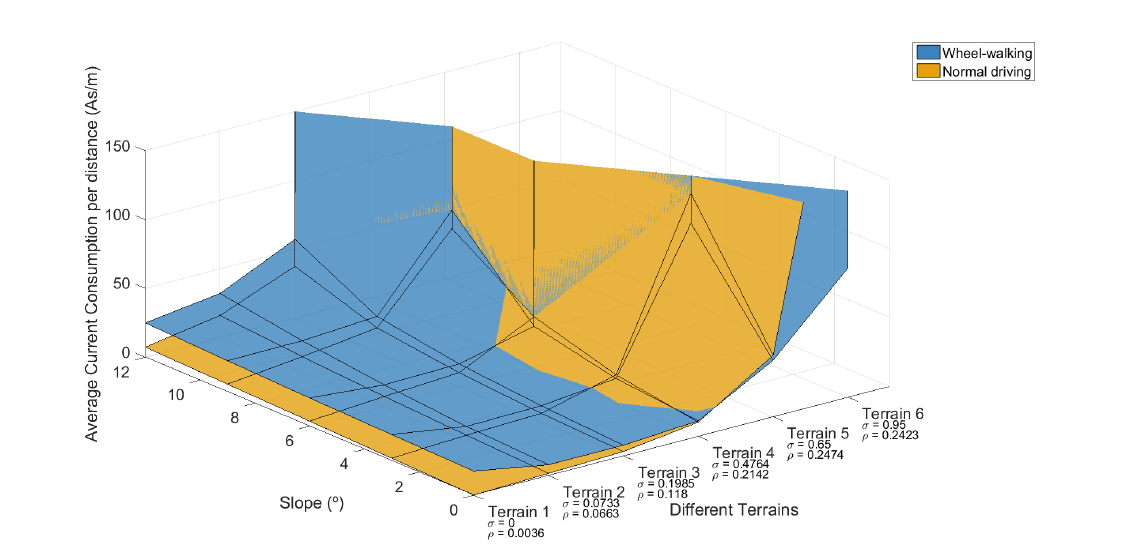
Figure 11. Relation between current consumption and speed of both locomotion modes, in function of slope and for different terrains. As shown, normal driving provides lower As/m than wheel walking for terrains 1 to 3. wheel walking shows a better performance in terrains 4 to 6 and slopes lower than 7 ◦ . Based in this information, Equation (23) has been defined to provide a score that indicates the best locomotion mode